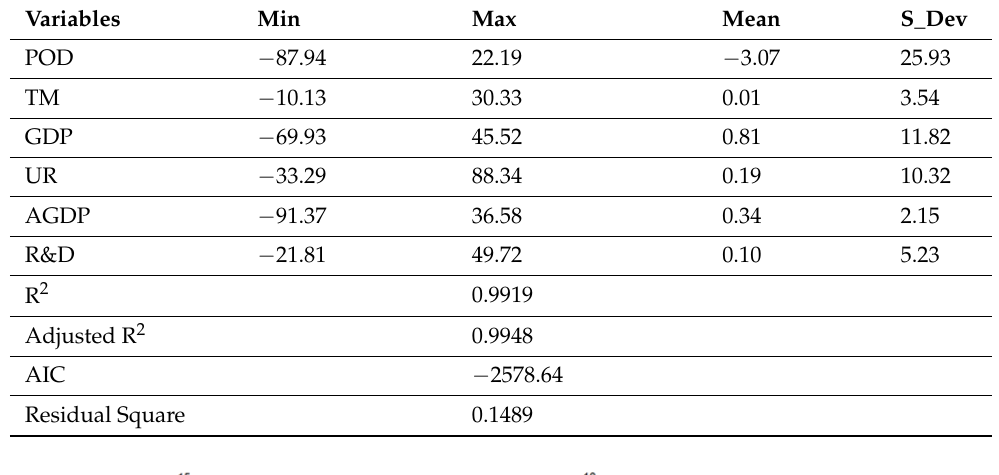
Table 3. Multiple collinearity test for WRECC.